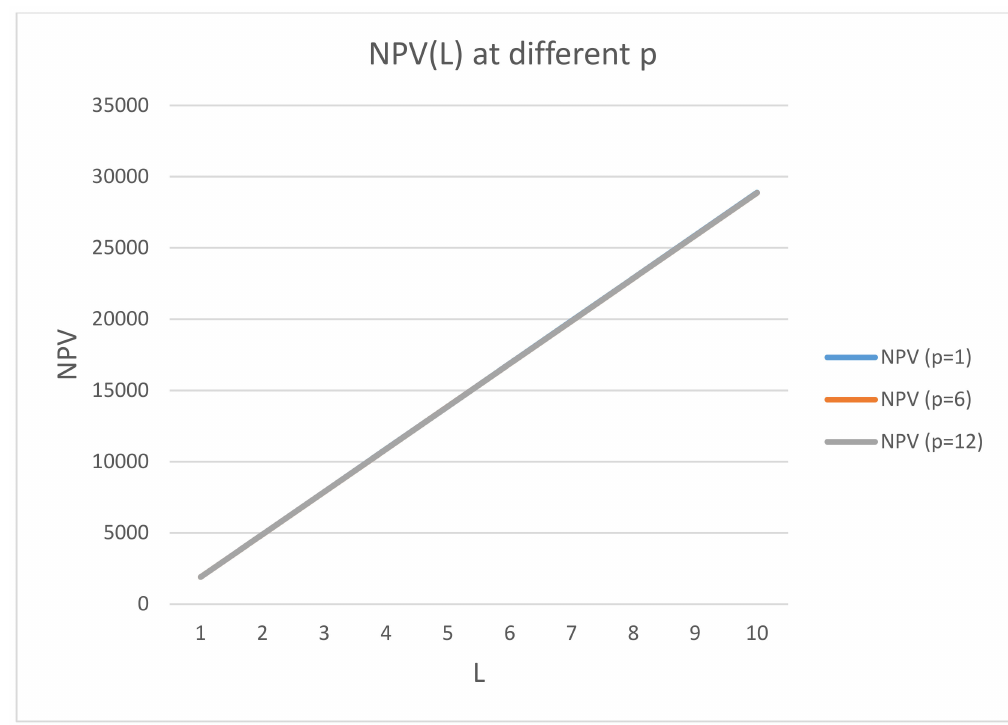
Figure 4. Dependence of NPV on leverage level L at k 0 = 0.22, k d = 0.14 and different p = 1, 6, 12 for a long-term project.